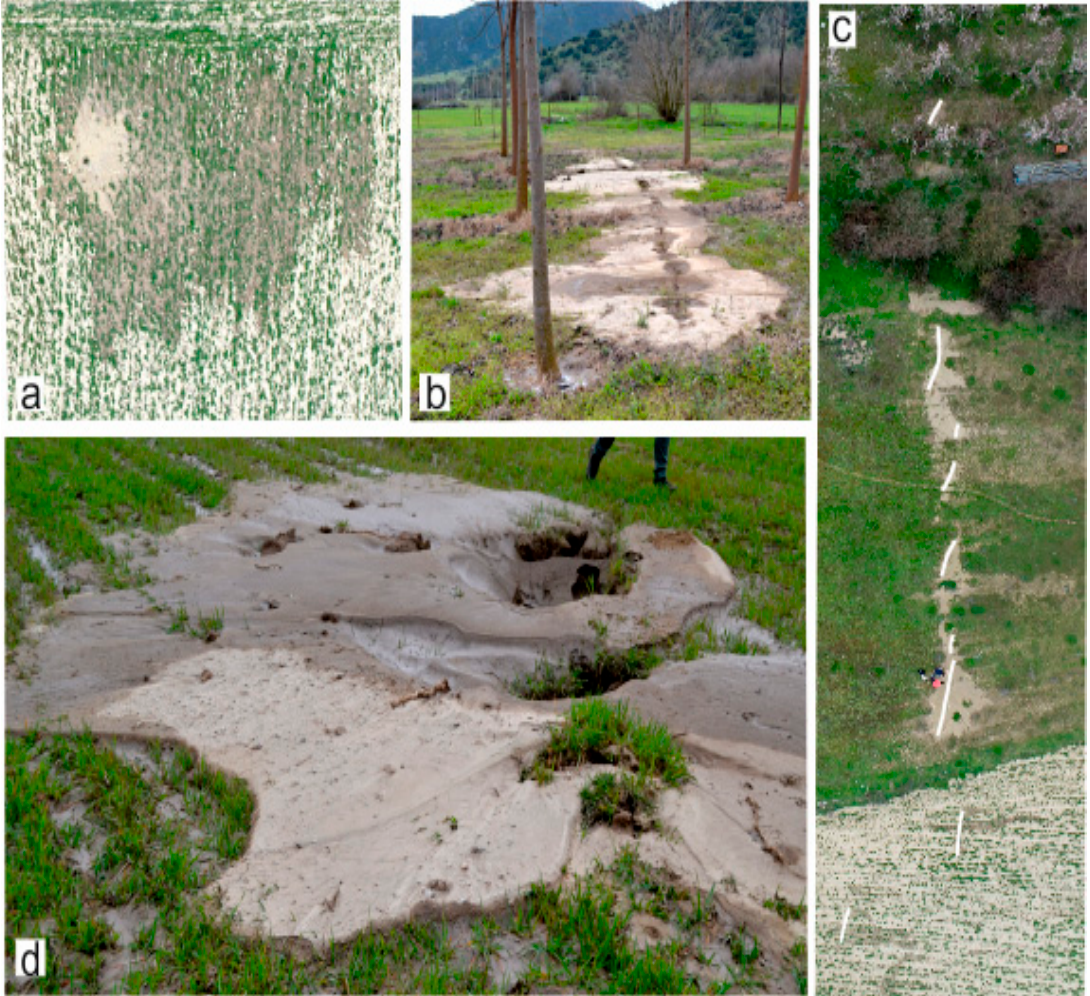
Figure 3. ( a ) Asymmetric sand blow with a single crater. Footage captured from a drone at a flight height of 80 m, width of photo 50 m. For this type of sand blow, local witnesses reported continuous water flow for at least 2-h after the M6.3 earthquake. ( b ) Field photograph of aligned and coalescent sand blows. Length of the series of blows is approximately 15 m. ( c ) Aerial view showing tens-of-meters long liquefaction features. These asymmetric sand blows developed parallel to Vlachogianni Fault. Note asymmetry of sand blows that is observed by water downslope movement and asymmetry in blow development. White lines emphasize the craters alignment. Overall length of observed feature is 75 m. ( d ) Multiple craters in a sand blow. Note dry sands in frontal part of picture and wet sands on back of photo. Pebbles in dry part of sand blow indicate their relationship with 3 March M6.3 Damasi earthquake, while wet material is related to 4 March 2021 M6.0 earthquake. Width of sand blow is about 5 m.